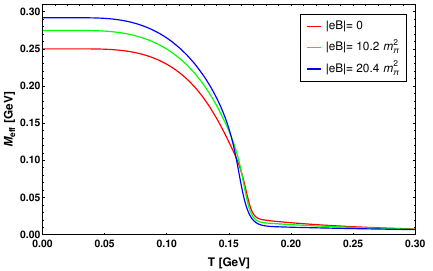
Figure 6. Plot of constituent mass as a function of T for di ff erent values of eB